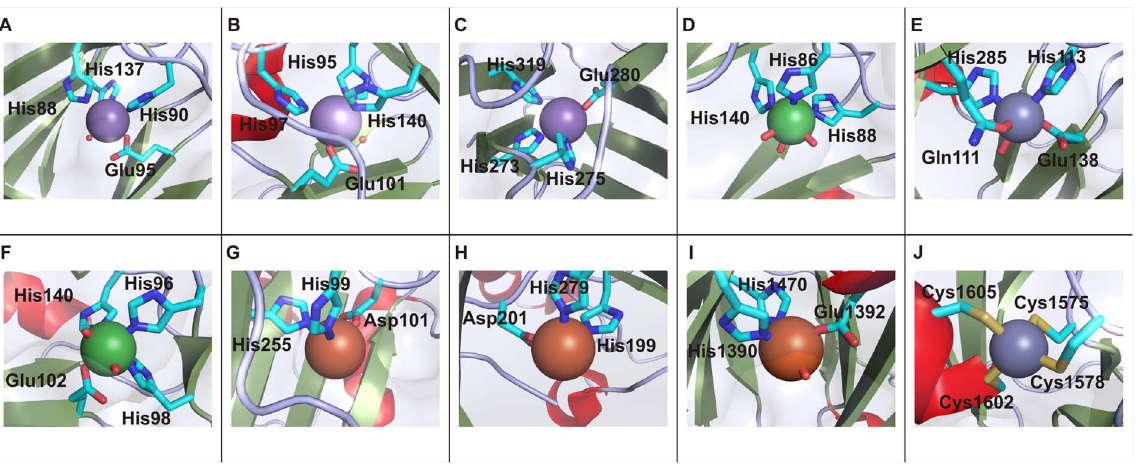
Figure 2. Metal-binding sites of representative members of the cupin superfamily. A. Mn ion of oxalate oxidase coordinated by His88, His90, Glu95, and His137 (PDB code: 2et1) [72], B. N-terminal Mn ion of oxalate decarboxylase coordinated by His95, His97, Glu101, and His140 (PDB code: 1uw8) [43], C. C-terminal Mn ion of oxalate decarboxylase coordinated by His273, His275, Glu280, and His319 (PDB code: 1uw8) [43], D. Ni ion of cysteine dioxygenase coordinated by His86, His88, and His140 (PDB code: 2q4s) [48], E. Zn ion of phosphomannose isommerase coordinated by Gln111, His113, Glu138, and His285 (PDB code: 1 pmi) [53] F. Ni ion of acireductone dioxygenase coordinated by His96, His98, Glu102, and His140 (PDB code: 1 zrr) [62], G. Fe ion of taurine/alphaketoglutarate dioxygenase coordinated by His99, Asp101, and His255 (PDB code: 1os7) [73], H. Fe ion of hypoxia-inducible factor 1-alpha inhibitor coordinated by His199, Asp201, and His279 (PBD code: 2y0i) [74], I. Fe ion of lysine-specific demethylase 6B coordinated by His1390, Glu1392, and His1470 (PDB code: 2 xue) [75], J. Zn ion of lysine-specific demethylase 6B coordinated by Cys1575, Cys1578, Cys1602, and Cys1605 (not part of the cupin domain) (PDB code: 2 xue) [75]. b -sheets are shown in green, a -helices are shown in red, and random coils are shown in grey. Spheres represent bound metal ions. Figures were generated using Pymol (The PyMOL Molecular Graphics System, Schro¨dinger, LLC).